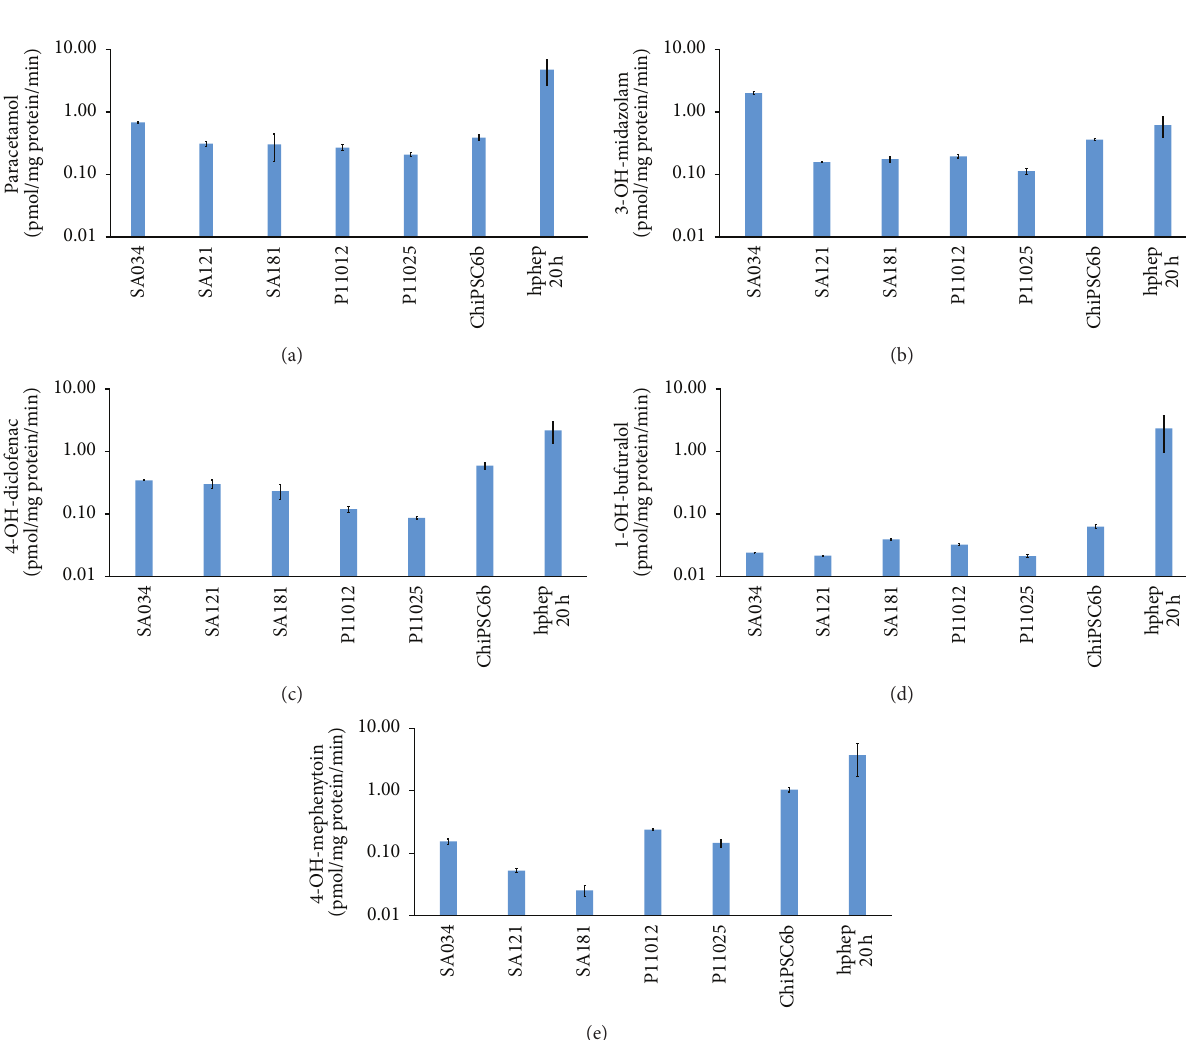
Figure 18: Cytochrome 450 enzymes (CYP) activities in hepatocytes derived from hPSCs (AS034, SA121, SA181, P11012, P11025, and ChiPSC6b) ( 𝑁 = 2 ) and cryopreserved human primary hepatocytes plated for 20 hr (hphep 20h) ( 𝑁 = 4 ). CYP activities in hepatocyte cultures were measured after 29 days of differentiation by the following assay: the cells were incubated with CYP enzymes substrates phenacetin (CYP1A), midazolam (CYP3A), diclofenac (CYP2C9), bufuralol (CYP2D6), and mephenytoin (CYP2C19). The concentrations of the resulting metabolites paracetamol, 3-OH-midazolam, 4-OH-diclofenac, 1-OH-bufuralol, and 4-OH-mephenytoin were determined by liquid chromatography/mass spectrometry. The results were normalized to mg protein per well and the duration of CYP activity assay. The CYP activity is presented as pmol metabolite per mg protein per minute (mean ± SEM). The 𝑦 -axis in log scale. (a) CYP1A, (b) CYP3A,